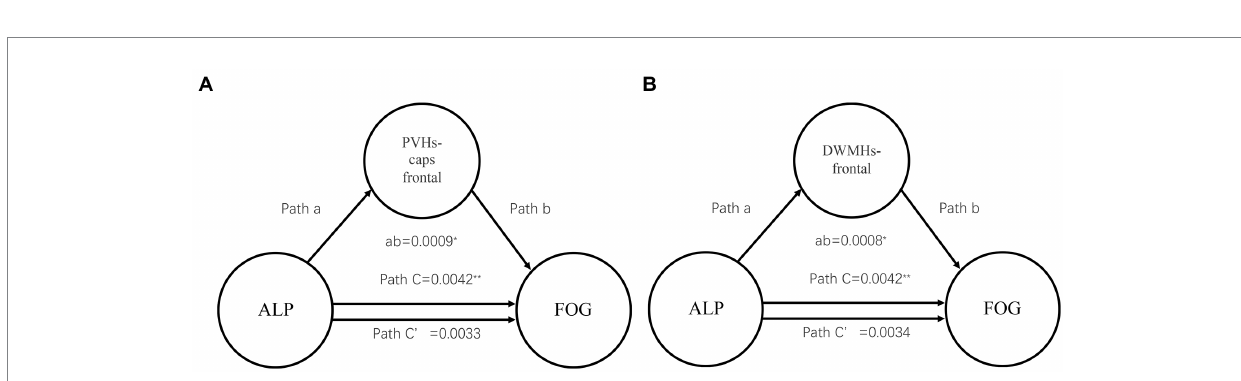
FIGURE 2 Mediation analysis about WMHs scores and ALP showing the mediation effects of ALP on FOG through WMHs. WMHs, white matter hyperintensities; ALP, Serum alkaline phosphatase; PVHs, periventricular hyperintensities; DWMHs, deep white matter hyperintensities; ** p < 0.01, * p < 0.05; (A) Mediation analysis about PVHs-frontal caps score and ALP; (B) Mediation analysis about DWMHs-frontal score and